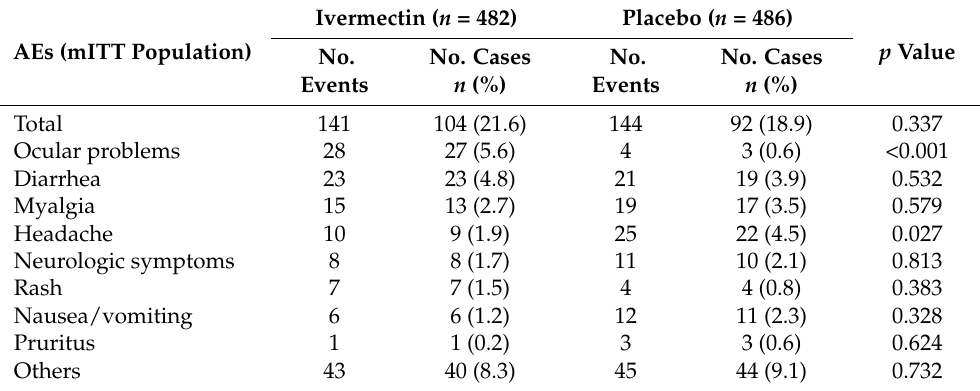
Table 5. Adverse events reported by all participants in the ivermectin prevention and treatment